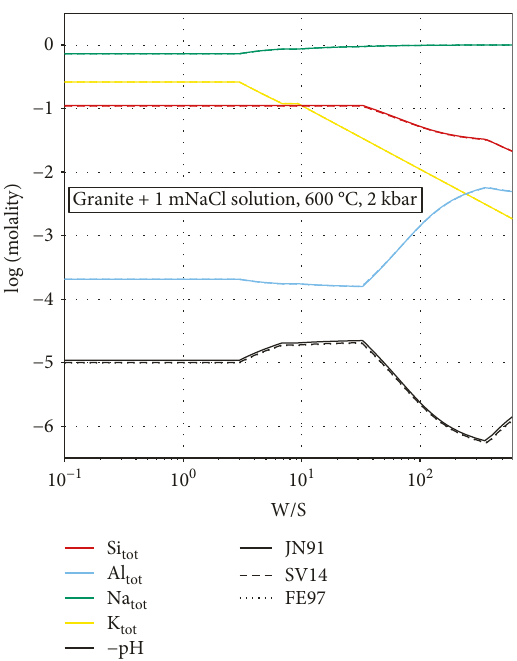
Figure 10: Calculated total elemental concentrations in the aqueous phase (1 NaCl mol/kg H O solution at 600 ° C and 2 kbar) in 2 equilibrium with granite (37 wt% albite, 30wt% quartz, 21wt% K- feldspar, and 12wt% muscovite) from 0.1 to 600 water-to-solid ratio (W/S), using the JN91, SV14, and FE97 models for water dielectric properties and IAPWS95 for water volumetric properties. Calculations done with SV14 overlap those done with